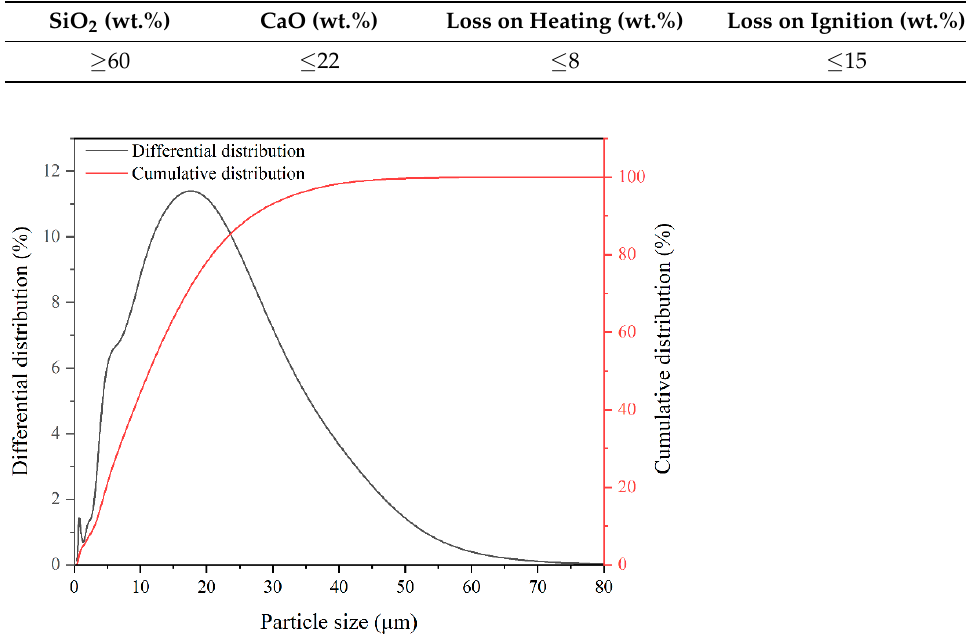
Table 1. Chemical composition and physical properties of ultrafine calcium silicate.